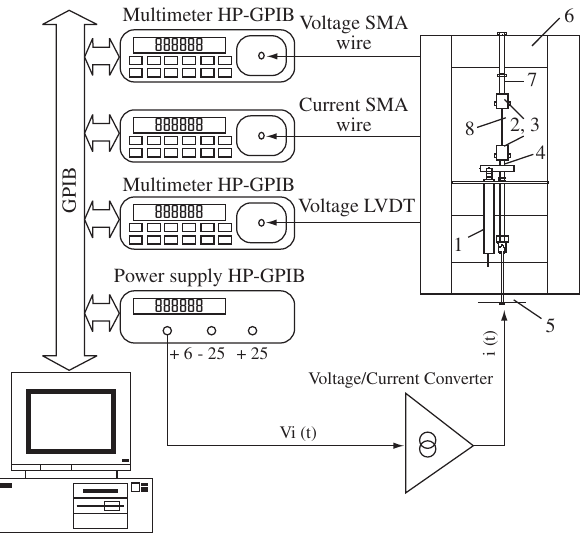
Figure 1. Mechanical structure of the testing bench and data acquisition system: 1) LVDT displacement sensor; 2, 3) mechanical grips; 4) guiding LVDT; 5) load (weight); 6) frame; 7) guiding rod; and 8) SMA wire.